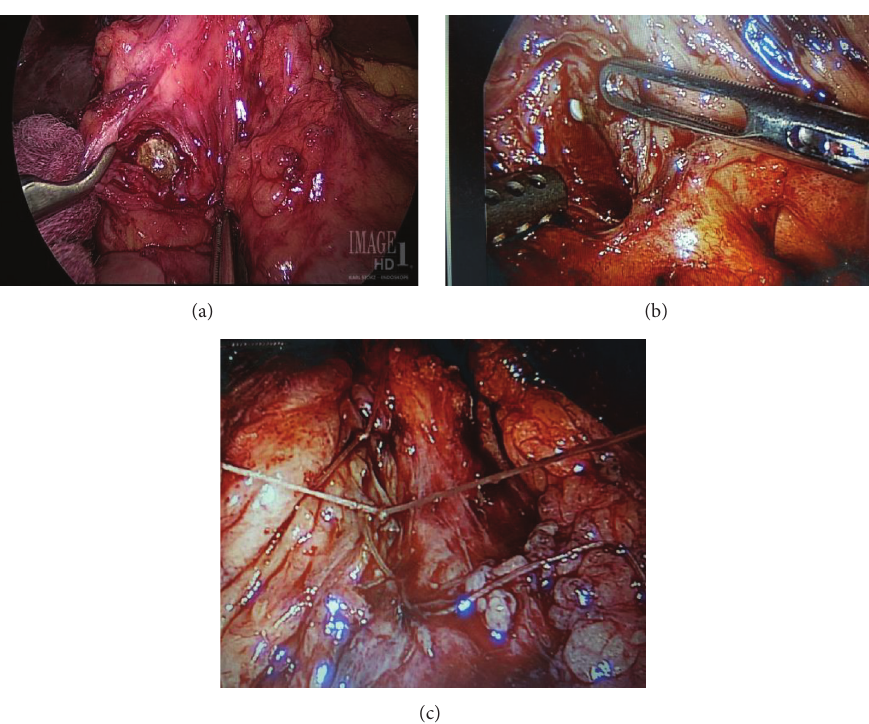
Figure 5: (a) Laparoscopic retrieval of remnant cystic duct stone. (b) Plastic common bile duct stent (pointed out by grasper) visible through the junction of cystic duct and common bile duct. (c) Laparoscopic intracorporeal closure of remnant cystic duct stump with absorbable suture.